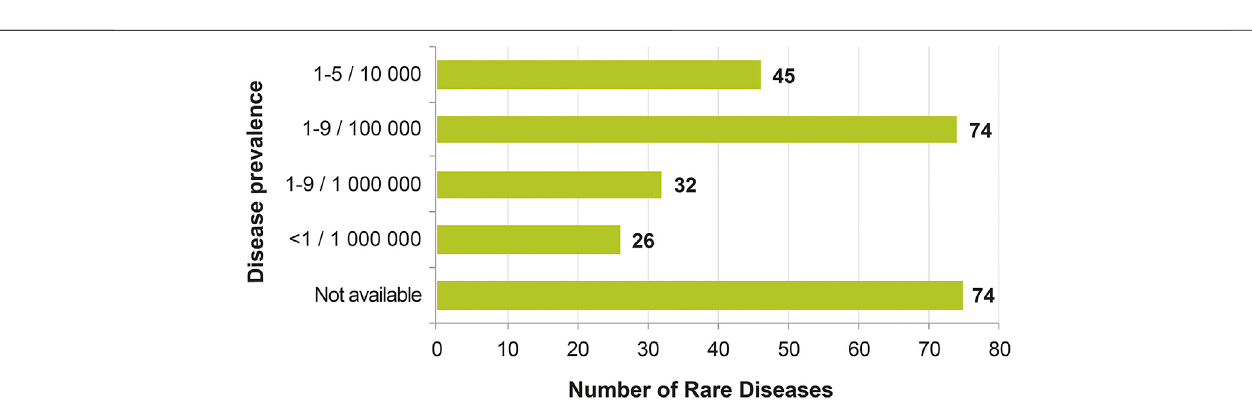
Frontiers in Pharmacology |